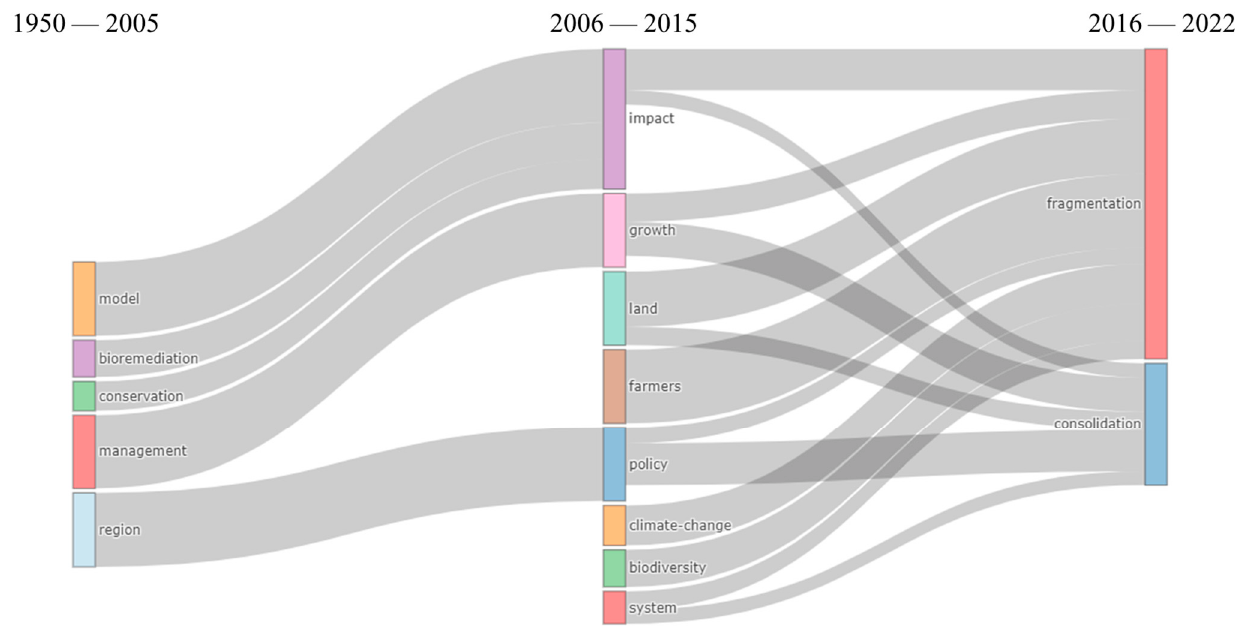
Figure 10. Evolution of topics in land consolidation and rural revitalization from 1950 to 2021.